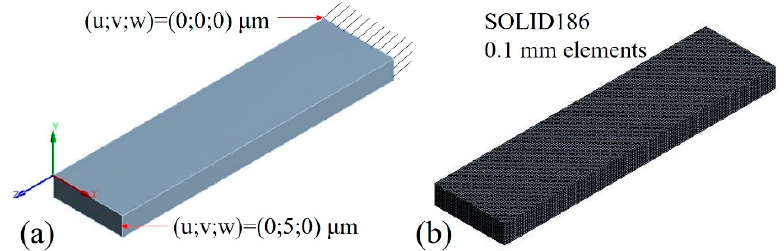
Figure 1. Representation of the finite element analysis (FEA): ( a ) boundary conditions, and ( b ) mesh.